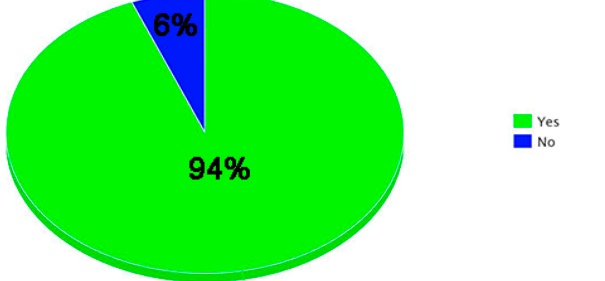
Figure 8. The % of high school students who want to continue to study and/or train at the end of this cycle of studies.